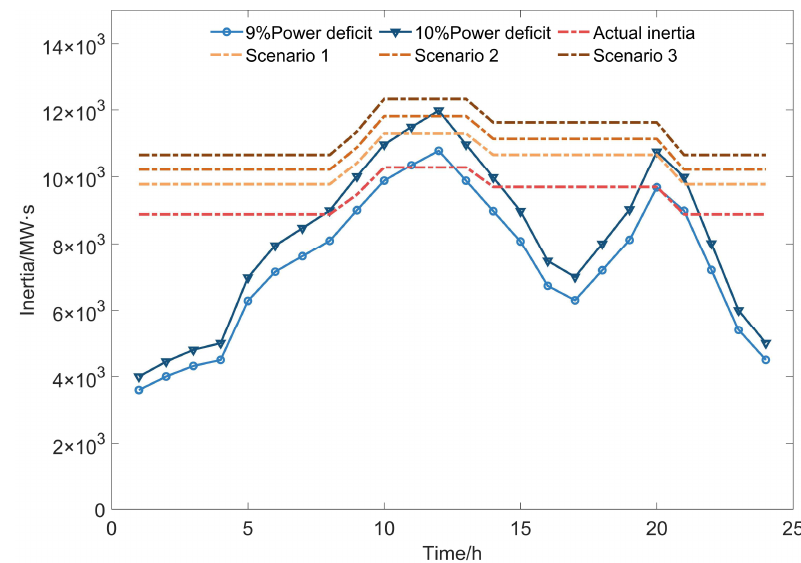
Table 1. Results for day-ahead scheduling costs. Figure 6. Results with different inertia margin coefficients for day-ahead scheduling.